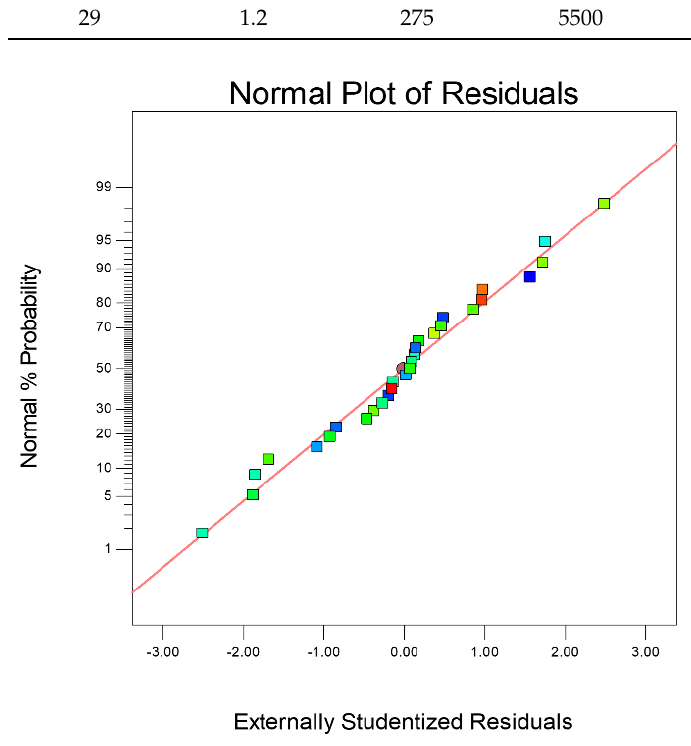
Figure 13. Normal plot of residuals.